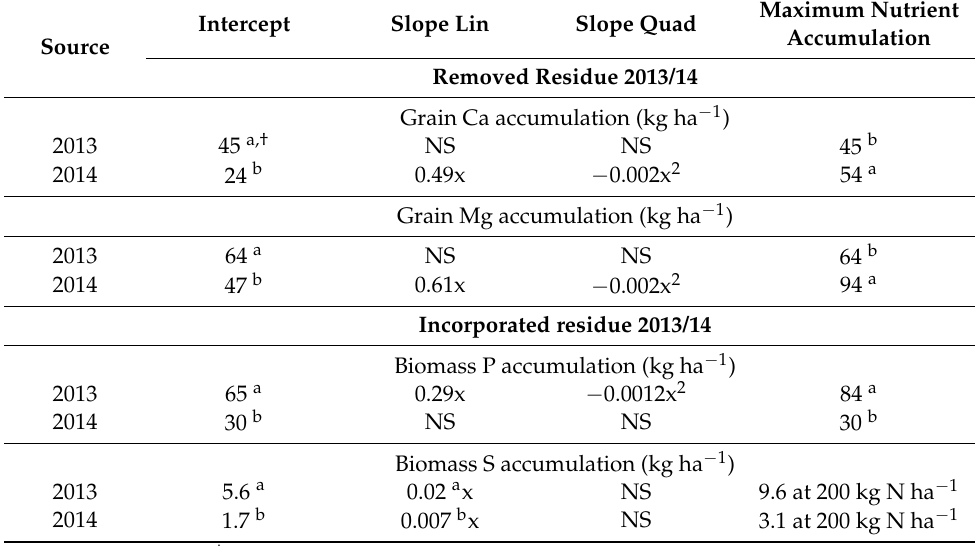
Table 2. Grain Ca and Mg accumulation and biomass P and S accumulation as a function of N rates and year (2013 and